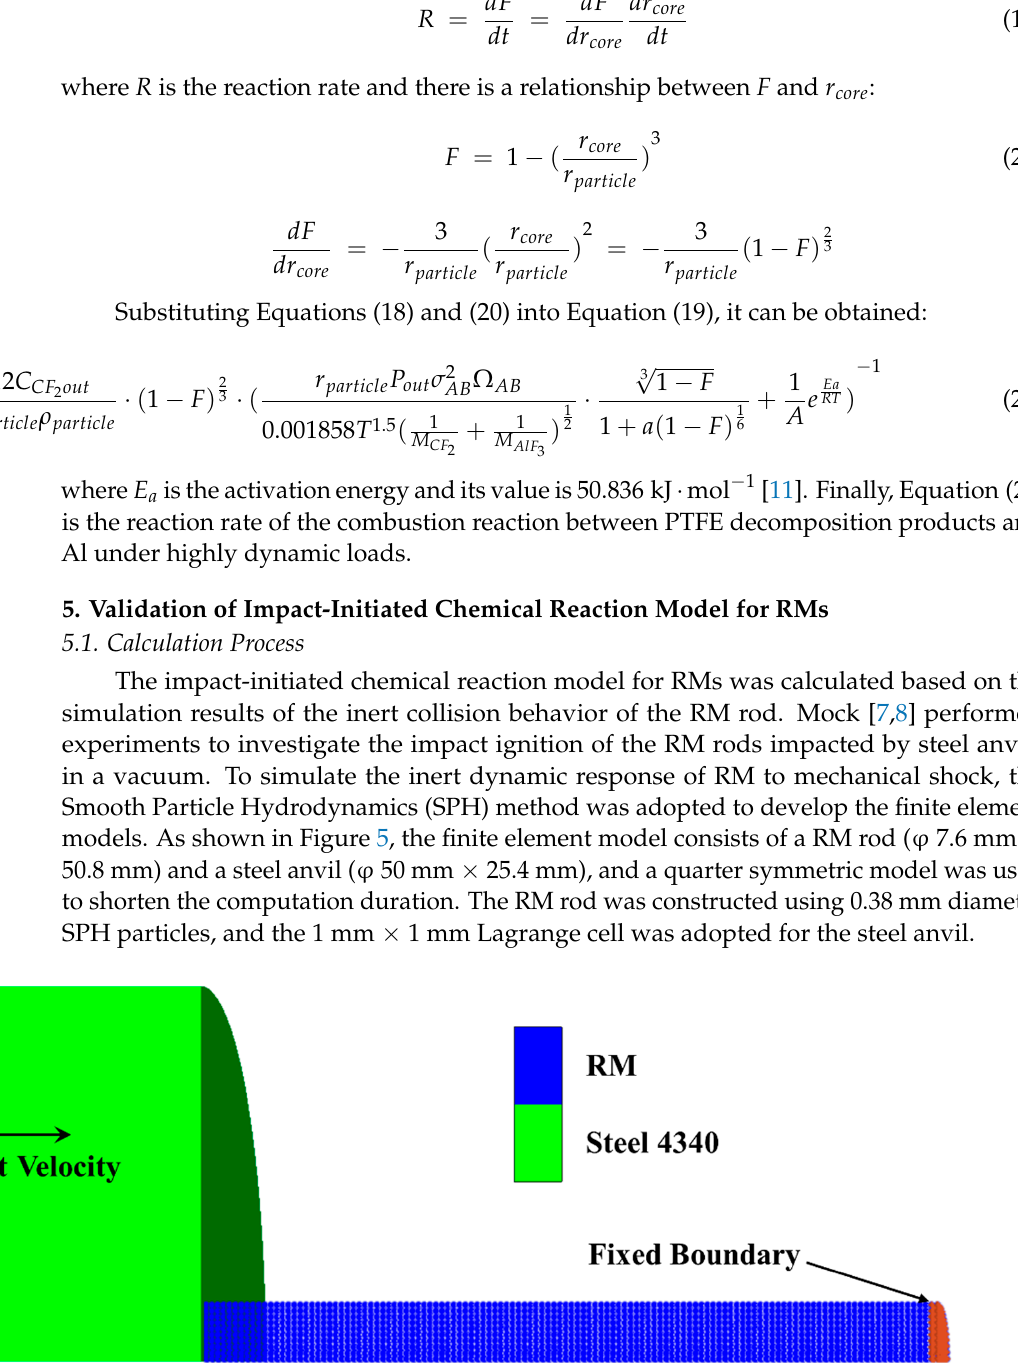
Figure 5. Scheme of simulation model.